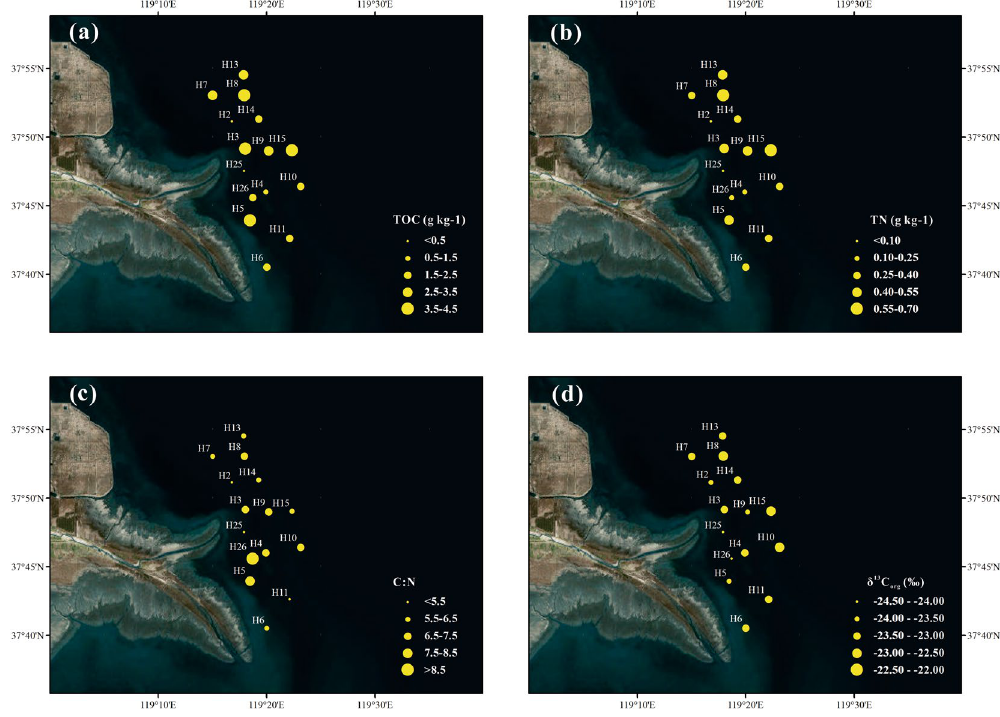
Figure 3. Spatial distributions of (a) TOC (g kg − 1 ), (b) TN (g kg − 1 ), (c) C:N, (d) δ 13 C org (‰) in surface sediments of the Yellow River Estuary. The maps were generated by ArcGIS 10.2 (http://www.esri.com/arcgis/ about-arcgis).